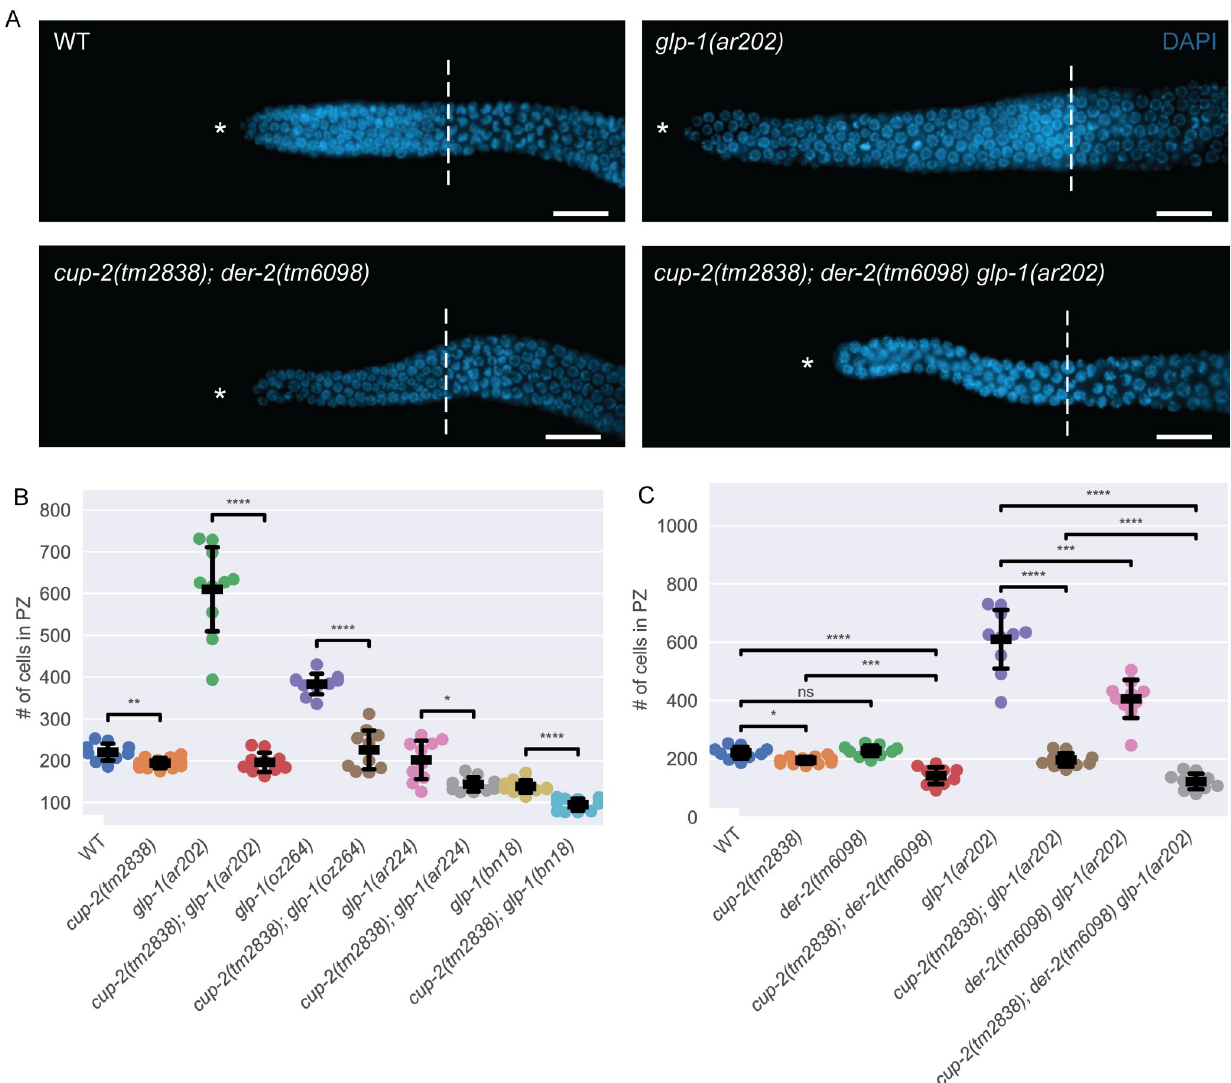
Fig 2. Derlin mutants have smaller proliferative zone sizes. A. Representative images of distal germlines of wildtype(WT), cup-2(tm2838); der-2 (tm6098) , glp-1(ar202) and cup-2(tm2838); der-2(tm6098) glp-1(ar202) worms stained by DAPI to visualize nuclei. Asterisk, distal tip. Dashed line, transition zone. Scale bar = 10 μ m. B. cup-2(tm2838) suppresses the proliferative zone sizes of glp-1(ar202) , glp-1(oz264) , glp-1(bn18) and germlines. Total number of cells in the proliferative zone of the indicated genotypes. C. Derlin mutants additively suppress the size of the proliferative zone of WT and glp-1 (ar202) germlines. Total number of cells in the proliferative zone of the indicated genotypes. In this and subsequent scatter plots, thick line = mean; error bars = standard deviation; t-test independent samples with Bonferroni correction; ns = 0.05 < p � 1; � = 0.01 < p � 0.05, �� = 0.001 < p � 0.01, ��� = 0.0001 < p � 0.001, ���� = p �